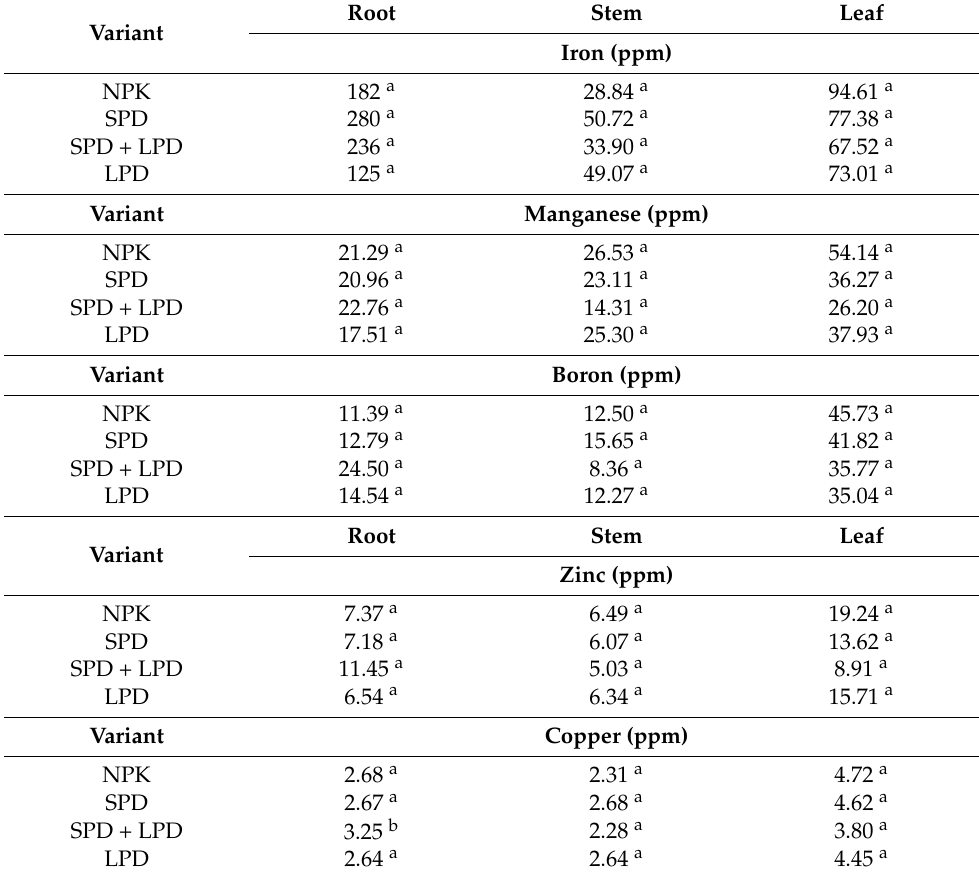
Different superscript letters indicate statistical